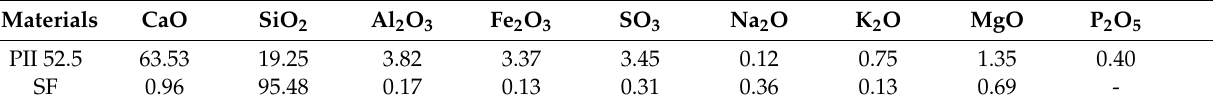
Table 1. Chemical composition of cement and silica fume, wt.%.